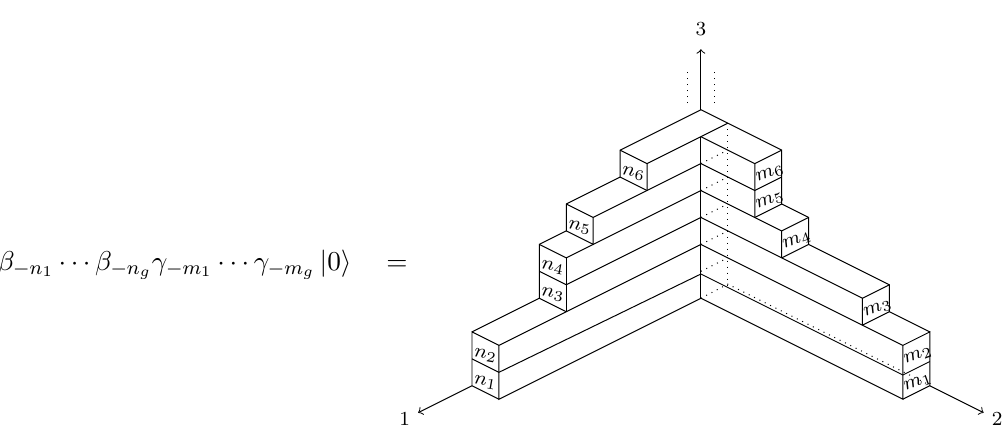
Figure 2 . The relation between Hilbert space of (cid:12)(cid:13) ghost and plane partition with a pit at (2,2,1). It can be decomposed into two Young diagrams. The left (right) one corresponds to the Hilbert space of (cid:12) ( (cid:13) ) ghost. The number written in each row means its length.